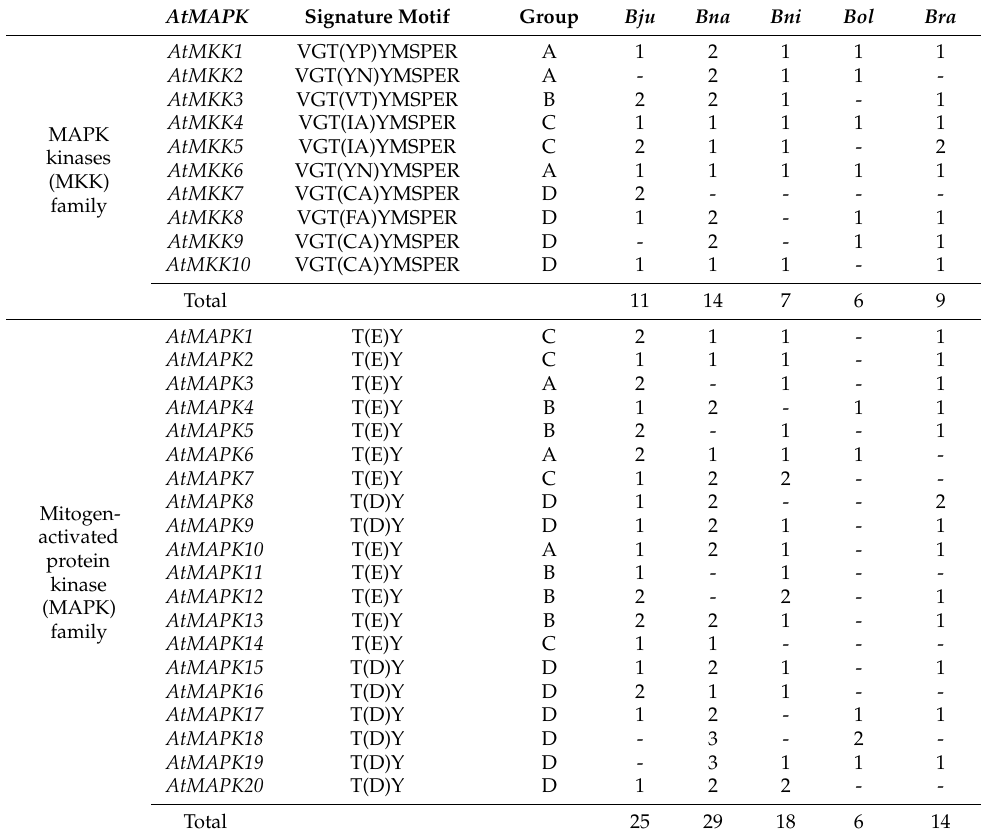
Table 1. Number of Brassica genes orthologous to Arabidopsis ( At ) MKK and MAPK genes identified from genome databases for five Brassica